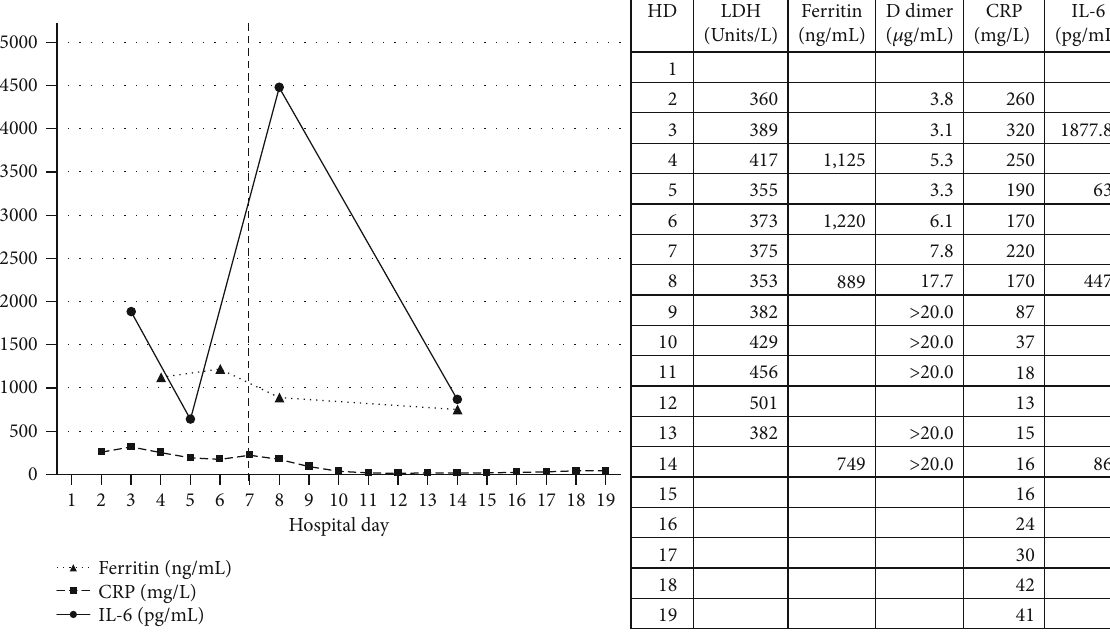
Figure 3: In fl ammatory markers before and after sarilumab (IL-6 receptor inhibitor) on HD7 as shown by the vertical dotted